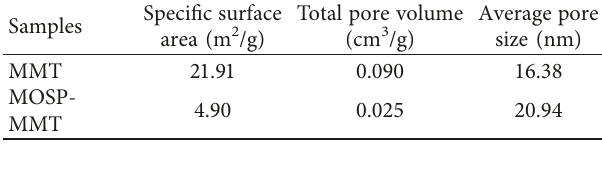
Table 1: BET parameters of MMT and MOSP-MMT.